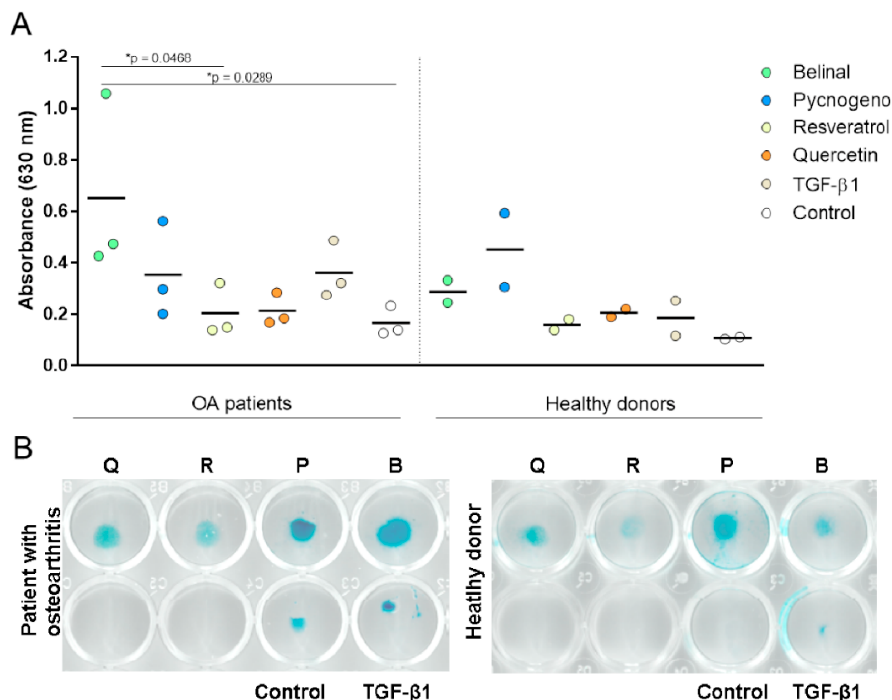
Figure 2. Chondrogenesis under non-inflammatory conditions. Chondrogenic differentiation was determinedusingthemicromassassay.( A )Primaryhuman(h)MSCsfrompatientswithhiposteoarthritis ( n = 3) and donors post mortem without musculoskeletal disorders (healthy donors, n = 2) were used to determine the e ff ects of the polyphenolic extracts and polyphenols on chondrogenesis. Micromasses were treated with the polyphenolic extracts and polyphenols, with the addition of TGF- β 1 for 7 days. Control micromasses received a medium without TGF- β 1. Alcian blue staining was performed to visualize the glycosaminoglycans formed. The absorbance of the extracted Alcian blue was then measured at 630 nm, as the measure of chondrogenesis. Significant benefits were seen for Belinal over the control and resveratrol treatments, as indicated (one-way ANOVA with Bonferroni correction). ( B ) Representative scans of the Alcian blue-stained glycosaminoglycans in the micromasses. B, Belinal; P, Pycnogenol; R, resveratrol; Q,